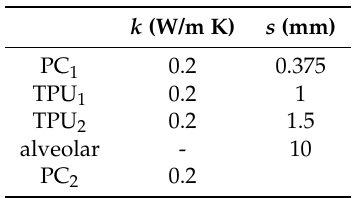
Table 1. Thermal properties and thickness of the photovoltaic system with active fluid cooling (PVFC) module. More details can be found in